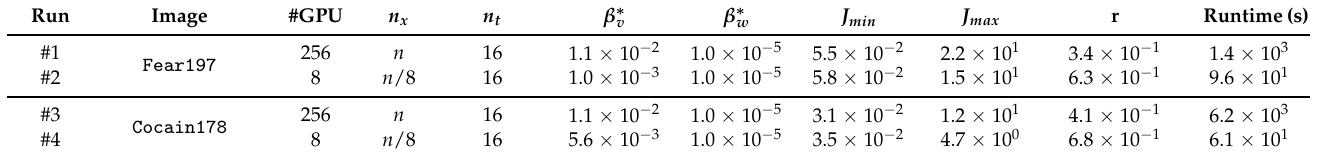
Table 9. Experiment 3: Registration performance for CLAIRE for the CLARITY imaging data at resolutions n = ( 2816,3016,1162 ) and n /8 = ( 328,412,1162 ) . Control182 is the fixed (reference) image. All other images selected from the CLARITY dataset are registered to Control182 using a